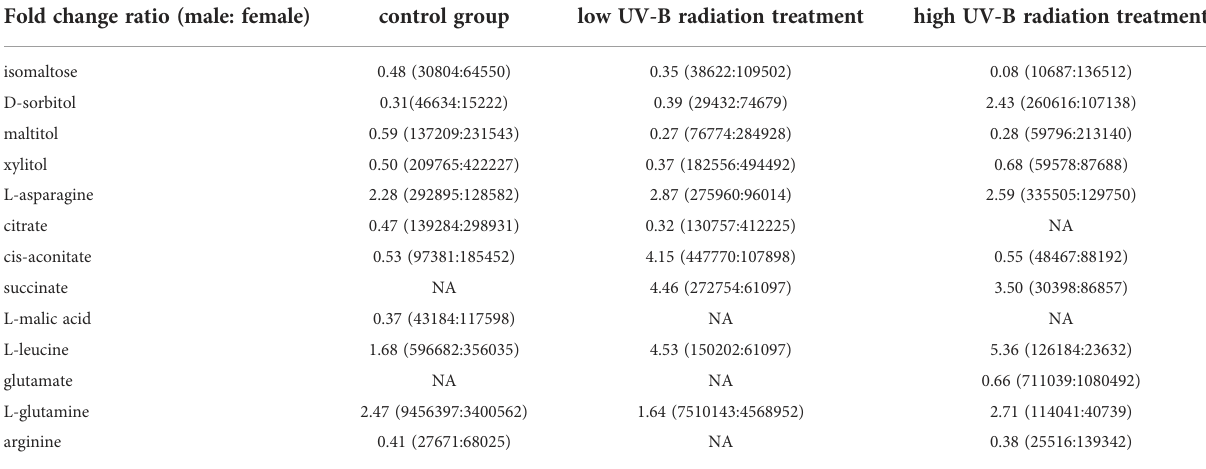
(The values in parentheses are from the results of metabolomic in our experiments, as measured by mass spectrometry). The numbers represent the fold change ratio between male and female S. thunbergii under different conditions. NA indicates there were no signi fi cant differences in metabolites between male and female S. thunbergii